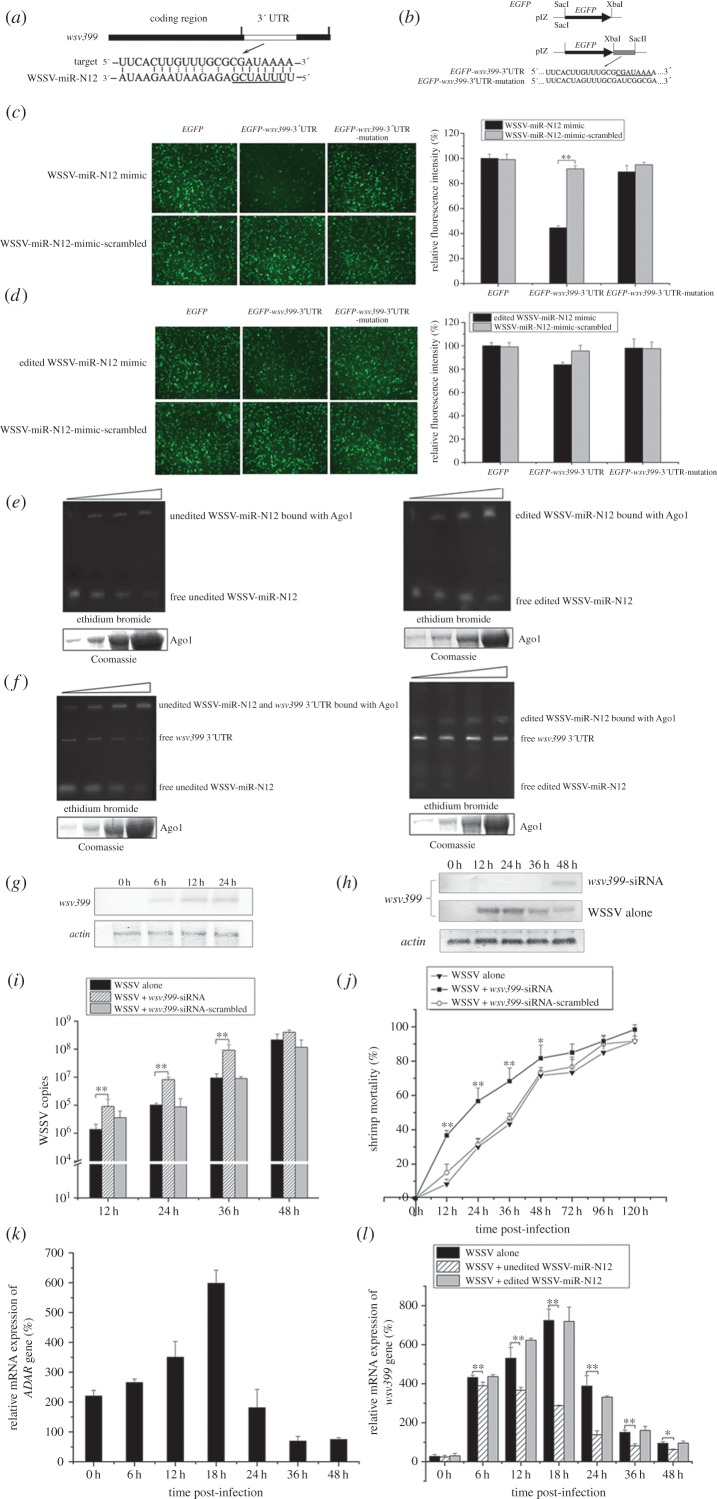
(Overleaf.) The mechanism of viral miRNA editing in virus infection. (a) The region of the viral gene wsv399 3′UTR targeted by WSSV-miR-N12. The seed sequence of WSSV-miR-N12 is underlined. (b) Constructs of EGFP-wsv399-3′UTR and EGFP-wsv399-3′UTR-mutation. The sequence targeted by WSSV-miR-N12 is underlined. (c) Direct interaction between WSSV-miR-N12 and wsv399 gene in insect cells. Insect High Five cells were cotransfected with the WSSV-miR-N12 mimic or WSSV-miR-N12-mimic-scrambled and EGFP, EGFP-wsv399-3′UTR or EGFP-wsv399-3′UTR-mutation. At 36 h after cotransfection, the fluorescence of cells was examined. (d) The interaction between the edited WSSV-miR-N12 and wsv399 gene in insect cells. Insect High Five cells were cotransfected with the edited WSSV-miR-N12 mimic and EGFP-wsv399-3′UTR. WSSV-miR-N12-mimic-scrambled, EGFP and EGFP-wsv399-3′UTR-mutation were used as controls. At 36 h after cotransfection, the fluorescence of cells was evaluated. (e) The interaction between edited or unedited viral miRNA and host Ago1 protein. The unedited or edited WSSV-miRNA-N12 was incubated with recombinant shrimp Ago1 protein, then separated by native polyacrylamide gel and stained with ethidium bromide to visualize the miRNA (top), followed by staining with Coomassie blue (bottom). The wedges indicated the concentration gradient of recombinant protein used. (f) The interaction between viral miRNA and its target gene in the miRISC. The unedited or edited WSSV-miRNA-N12 and the 3′UTR of the wsv399 gene were incubated with shrimp Ago1 protein. Subsequently, the mixture was separated by agarose gel and stained with ethidium bromide to show the miRNA and target gene, followed by staining with Coomassie blue (bottom). The wedges indicate concentrations of recombinant protein used. (g) Northern blot analysis of expression profiles of the wsv399 gene in WSSV-infected shrimp. The shrimp were challenged with WSSV. Numbers indicated the time points post-infection. Shrimp β-actin was used as a control. (h) Silencing of wsv399 expression in WSSV-infected shrimp. The wsv399-siRNA and WSSV was co-injected into WSSV-infected shrimp. Then the shrimp haemolymph was subjected to northern blot analysis to detect the expression level of the wsv399 gene. Numbers indicate the time points post-infection. Shrimp β-actin was used as a control. (i) Effect of wsv399 gene silencing on WSSV copies in shrimp. The shrimp were simultaneously injected with WSSV and wsv399-siRNA, followed by detections of virus copies with quantitative real-time PCR. As controls, WSSV alone and wsv-399-siRNA-scrambled were included in the injections. (j) Accumulative mortalities of WSSV-infected shrimp. At different times post-infection, the accumulative mortalities of shrimp were monitored daily. Numbers showed the time points post-infection. (k) The detection of ADAR expression in virus-challenged shrimp. Shrimp were infected with WSSV. At different times post-infection, the ADAR mRNA level was evaluated with quantitative real-time PCR. (l) The examination of wsv399 expression. The wsv399 mRNA in shrimp treated with WSSV and unedited or edited WSSV-miR-N12 was quantified with quantitative real-time PCR. In all panels, the statistically significant differences between treatments were represented with asterisks (*p < 0.05; **p < 0.01).